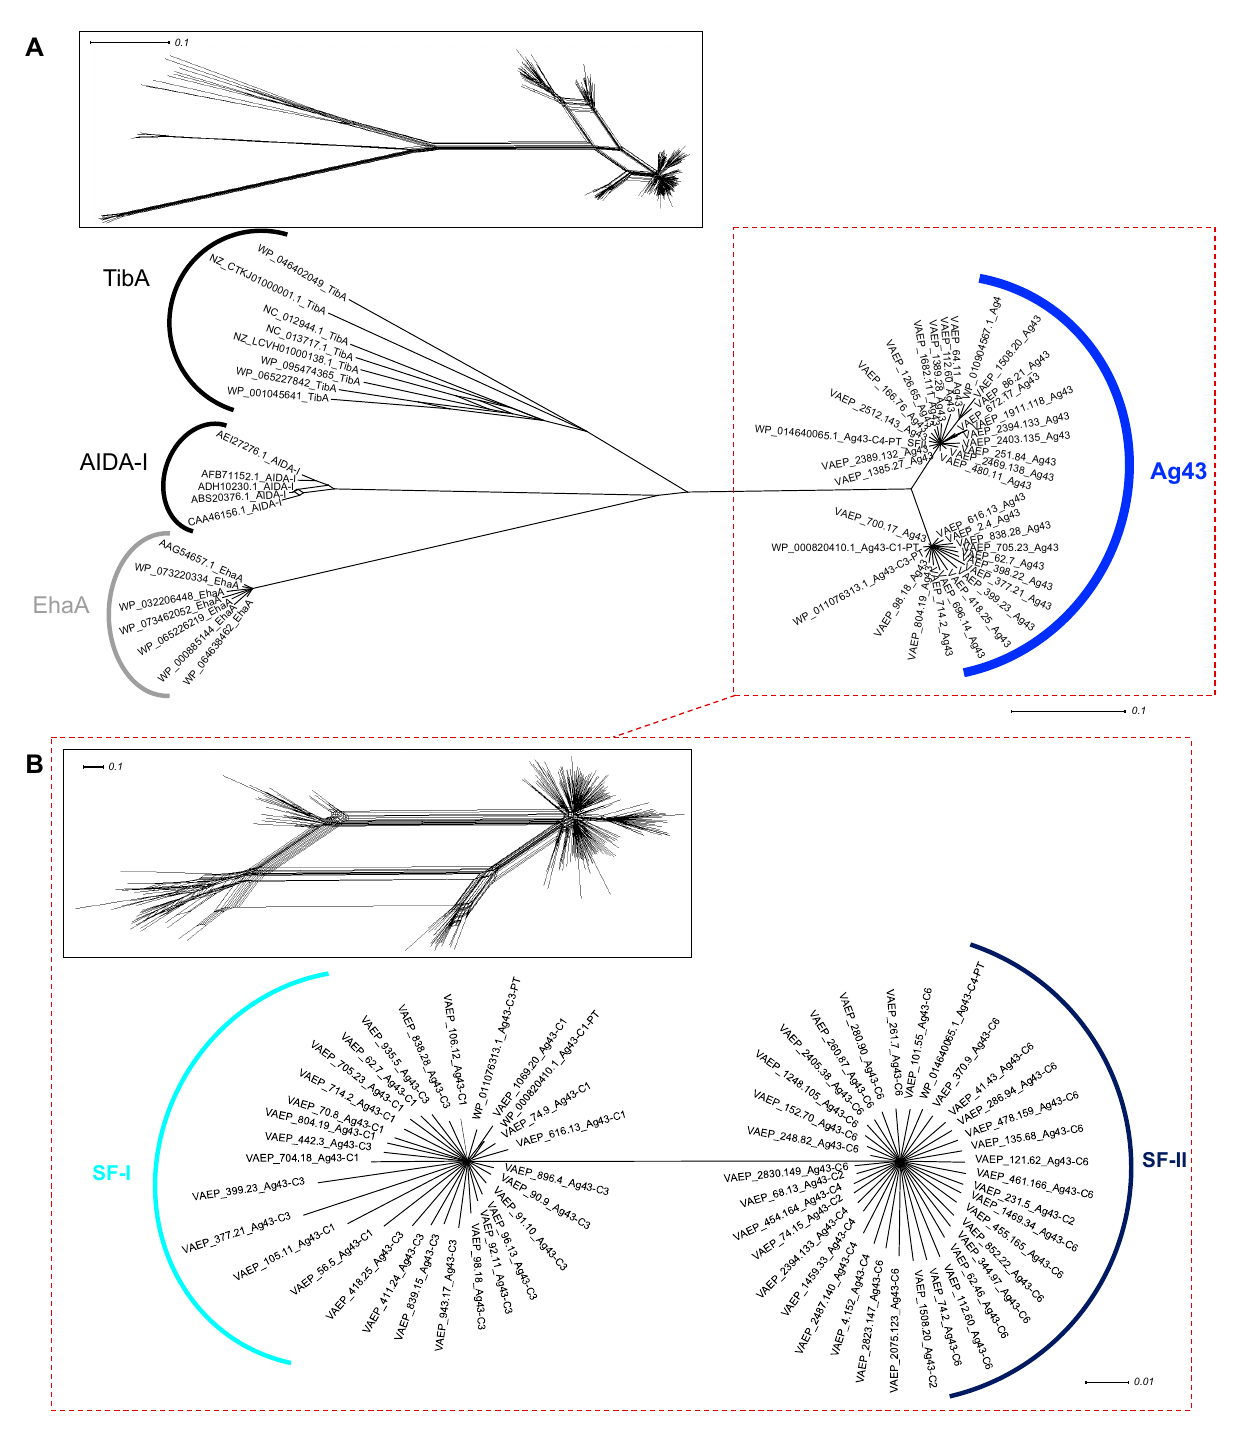
Figure 2. Phylogenetic analysis of Ag43 and other SAATs. Trees were generated using SplitsTree and the inserts represent the trees before applying bootstrapping and confidence threshold. ( A ) Full- length amino acid sequences of Ag43 respective to other SAATs, namely TibA and AIDA-I [4,7,32]; EhaA was used as an outgroup (in grey). ( B ) Phylogenetic analyses of Ag43, highlighting the two subfamilies previously reported, namely SF-I and SF-II [18]. For legibility, sequences that were identified but not presented here are available in supplementary Table S1. Scale bars represent the evolutionary distance, i.e., the number of substitutions per site.